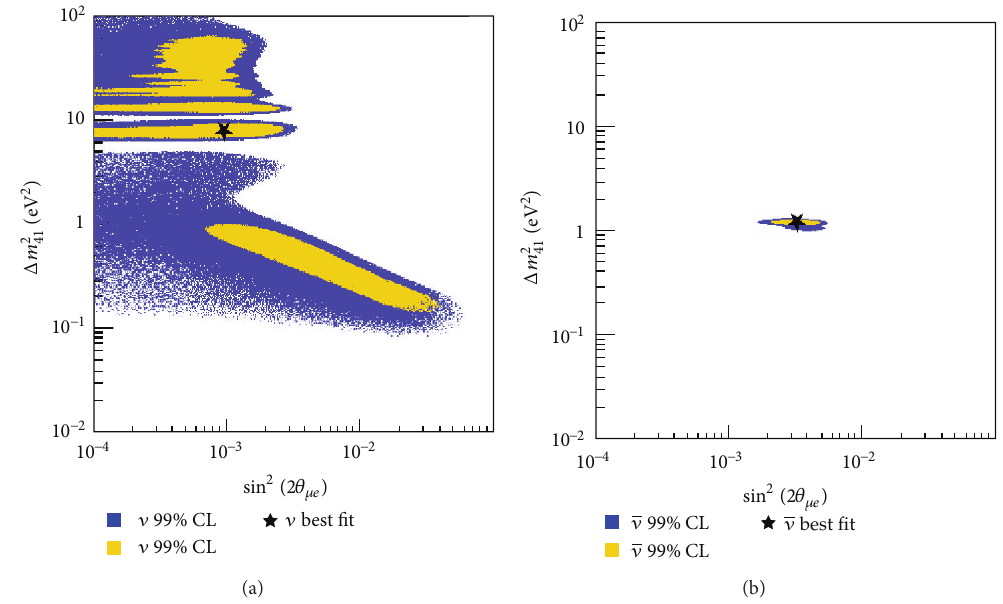
Figure 5: The Δ𝑚 2 41 versus sin 2 2𝜃 𝜇𝑒 allowed space from fits to neutrino (a) and antineutrino (b) data in a ( 3 + 1 ) model.